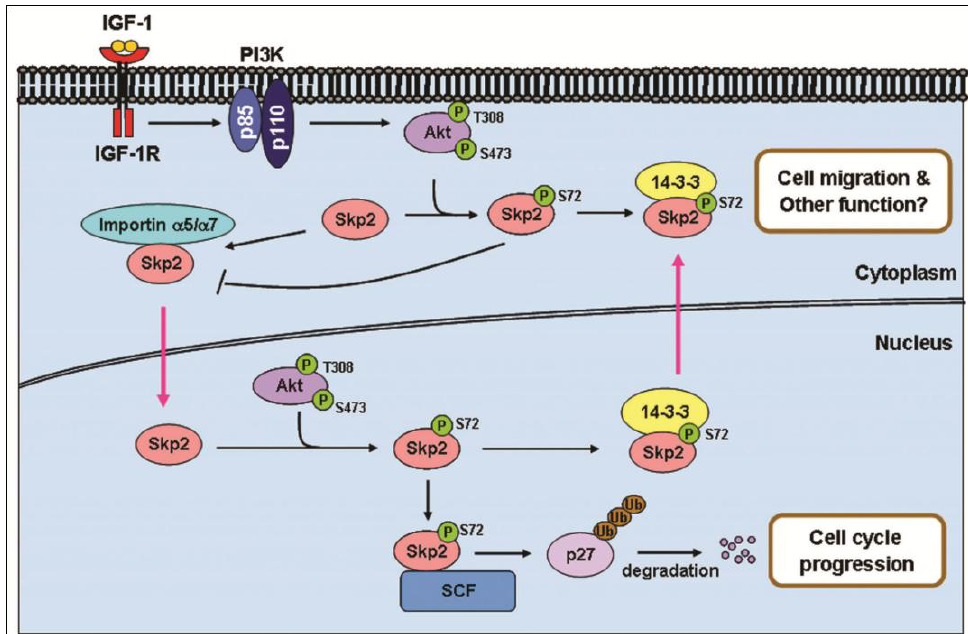
FIGURE 4. Akt-mediated phosphorylation of Skp2 regulates Skp2 cytosolic localization and functions. Upon IGF-1 stimulation, phosphorylation of nuclear Skp2 at Ser 72 by Akt promotes the interaction of Skp2 with 14-3-3, in turn facilitating Skp2 cytosolic localization. Phosphorylation of cytosolic Skp2 at Ser 72 prevents the interaction of Skp2 with importin  5 and  7, in turn preventing Skp2 nuclear import. One of the cytosolic Skp2 functions is to